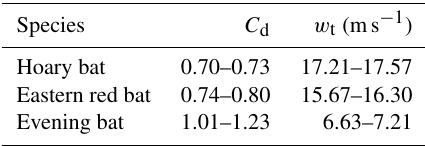
Table 5. Sampled range of drag coefficients and terminal velocities for three species of bat